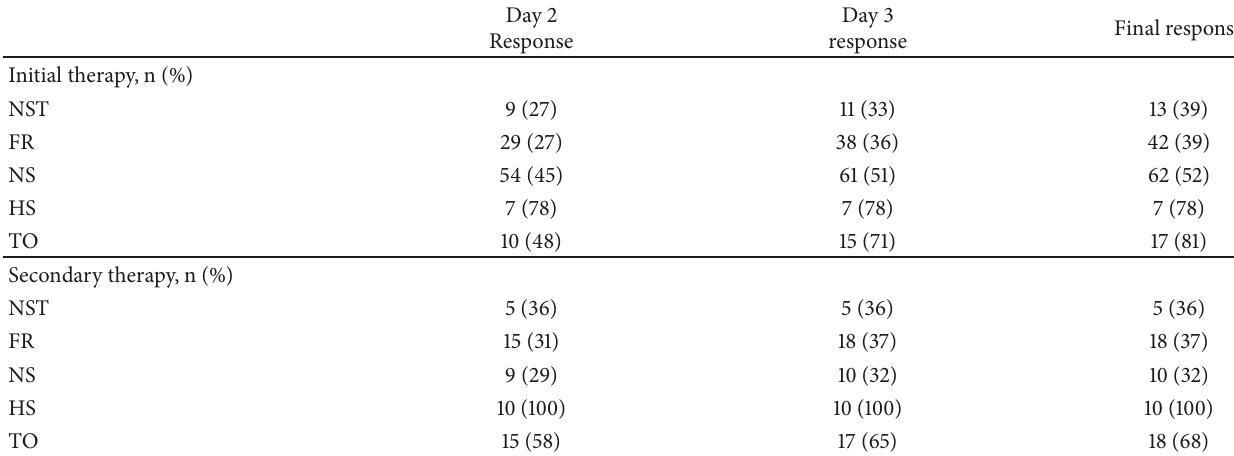
a Patients with initial moderate or severe hyponatremia. Initial therapy P < 0.05 for Day 2 response : no specific therapy (NST) vs hypertonic saline (HS), and fluid restriction (FR) vs HS and isotonic saline (NS); Day 3 response: NST vs HS and tolvaptan (TO); FR vs HS, NS, and TO: final response: NST vs TO, FR vs HS and TO, and NS vs TO.